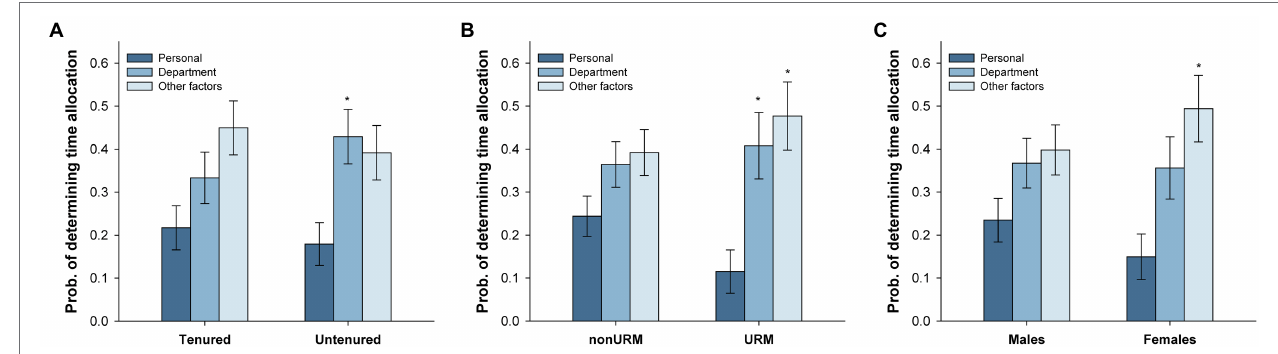
FIGURE 2 | Perceived reasons for current time allocation. Tenured vs. untenured (A) , nonURM vs. URM (B) , and male vs. female (C) faculty estimated the extent to which their current effort distribution was guided by personal preferences, departmental pressures, or other institutional factors (e.g., institutional policies and available resources). * p adj < 0.05 for comparisons between personal preferences, and departmental and institutional pressures. Brackets represent the standard error of the